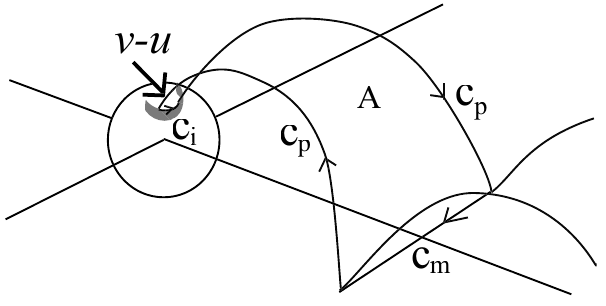
Fig. 2. The geometry for estimating the reconnection rate from ion flow across the open-closed boundary in the nightside